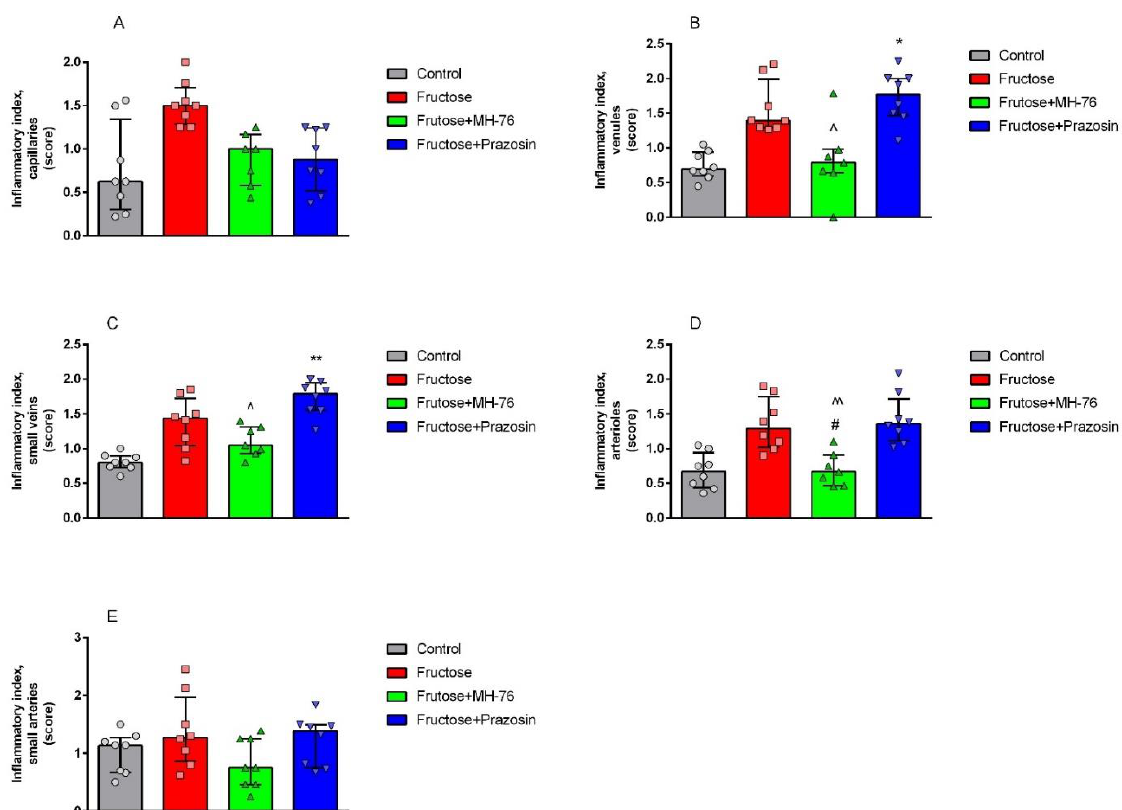
Figure 8. Inflammatory index of microvasculature (( A ) capillaries, ( B ) venules, ( C ) small veins, ( D ) arterioles, ( E ) small arteries) of abdominal adipose tissue in the different groups of rats. The assessed changes included: endothelial damage, leukocyte adhesion, and extravasation, perivascular lymphocyte and macrophage aggregation. The analysis was carried out with a 40× (and 100× for endothelial damage and extravasation analyses) objective magnification, data on a 0–3 semi-quantitative scale. Separate data for the above four components were collected as a common indicator of inflammatory lesions. Data are expressed as median + IQR, * p < 0.05, ** p < 0.01 versus Control, # p < 0.05 versus Fructose, ^ p < 0.05, ^^ p < 0.01 versus Fructose + Prazosin, (Kruskal–Wallis test by ranks, post hoc Dunn test).